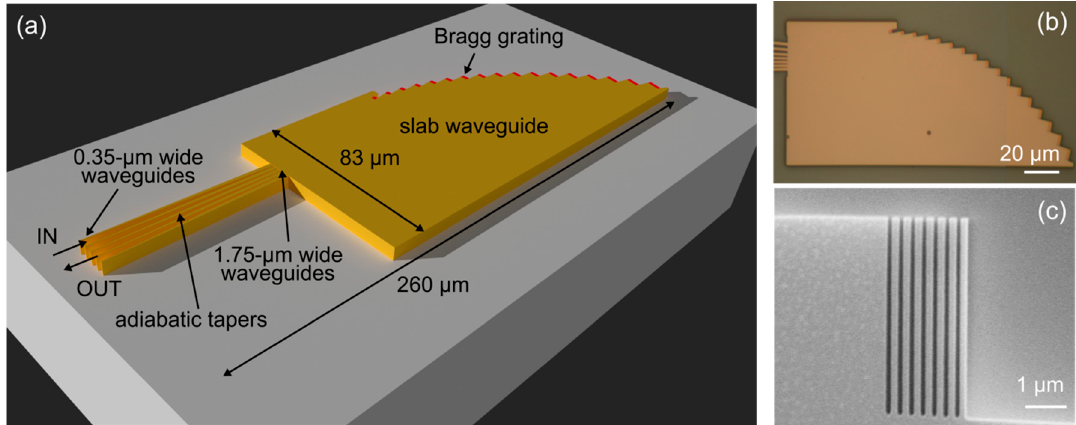
Figure 1. ( a ) Schematic of the 1 × 4 silicon-on-insulator (SOI) echelle grating demultiplexer, including the input and output waveguide tapers—from 0.35 µ m width (single mode waveguide) to 1.75 µ m at the edge of the slab. ( b ) Optical microscope photograph of one of the fabricated devices and ( c ) scanning electron microscope picture of the Bragg grating reflector used at the grating facets.